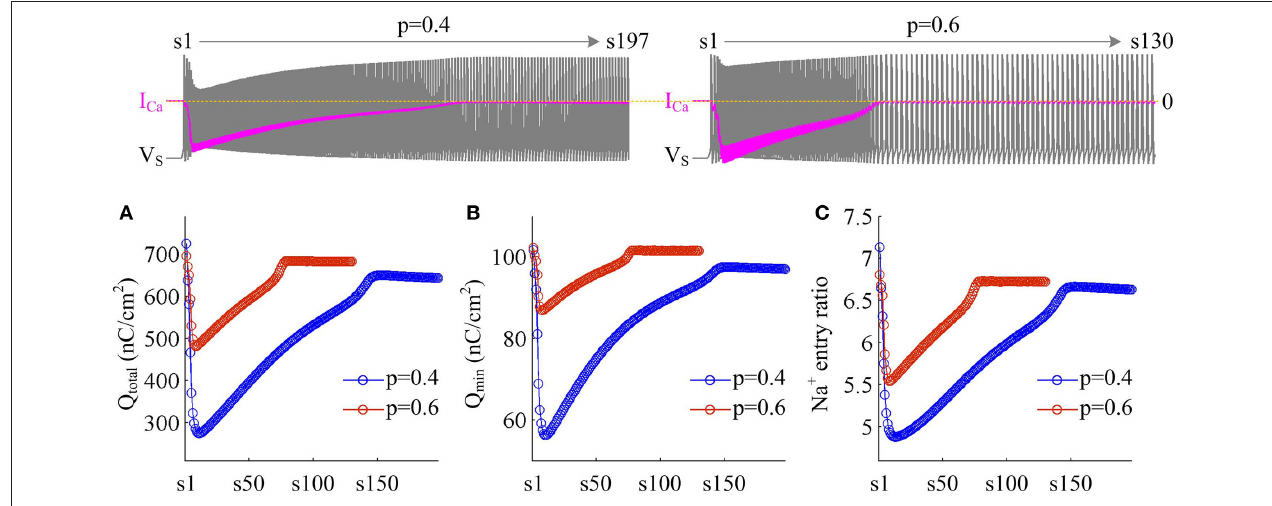
FIGURE 7 | Dendritic Ca 2 + spike increases metabolic efficiency of APs. (A) Total Na + load Q total , (B) minimal Na + load Q min , and (C) Na + entry ratio are respectively computed for each AP during the activation of I Ca with p = 0.4 and 0.6. Top panels show the response of V S (gray) and I Ca (pink) recorded in the model II with each value of p . I D = 5 µ A / cm 2 and g c = 0.3 mS / cm 2